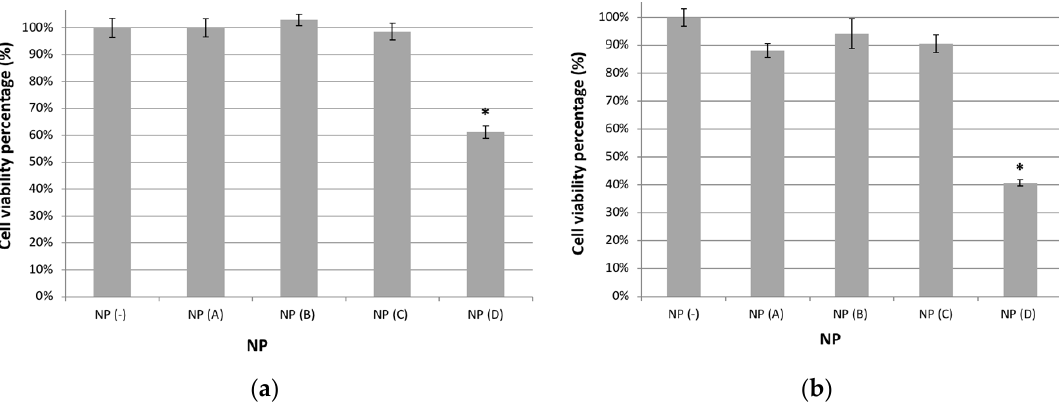
Figure 10. MTT cell viability assay for Jurkat tumor cells incubated with the indicated type of NP at 1.5 μg/mL ( a ) or 15 μg/mL ( b ). Percentage of viable cells as compared to cells cultured in the absence of NP (considered as 100% viability) is shown. Mean and standard error are shown for each sample. A representative experiment out of three is shown. Statistically significant differences ( p < 0.05) are marked with a star (*).